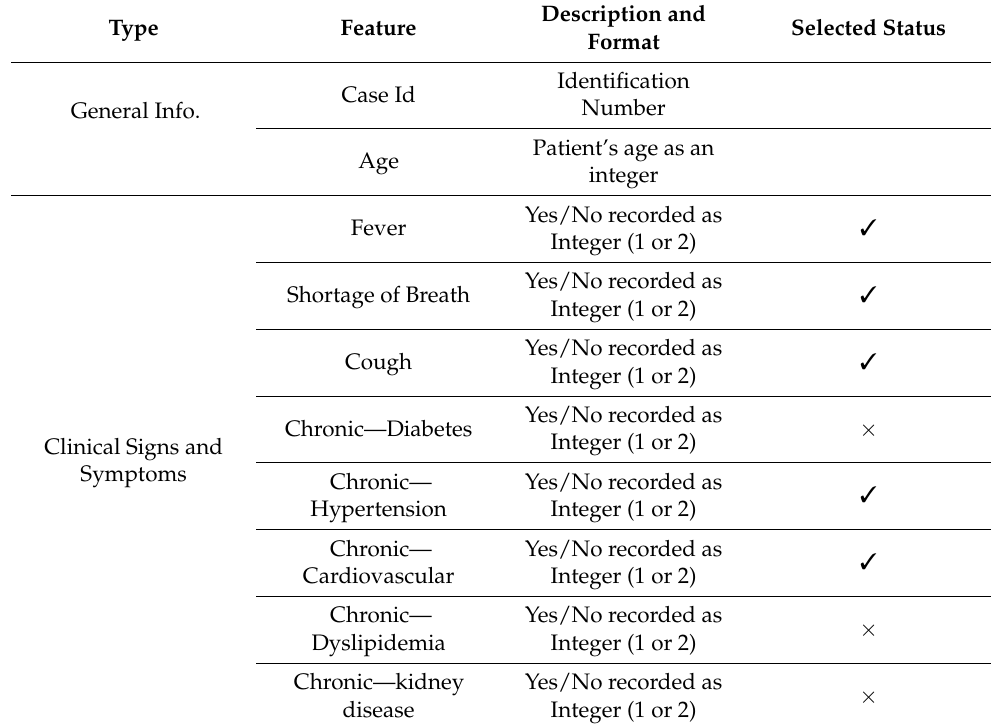
Table 11. KFUH dataset description.